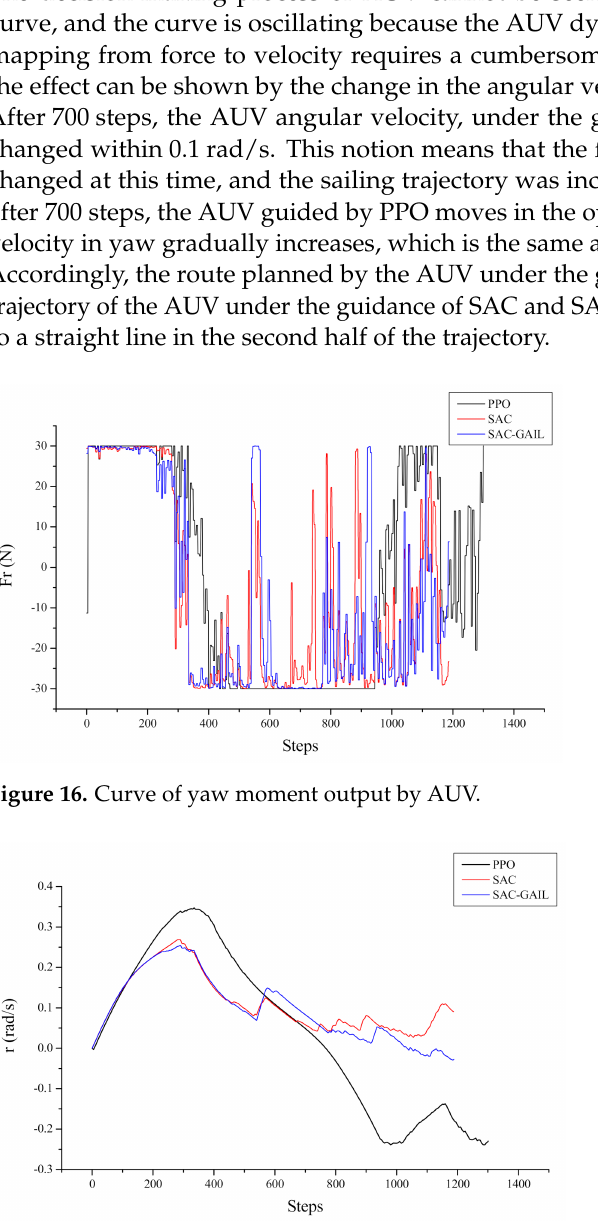
Figure 17. Curve of angular velocity in the yaw output by